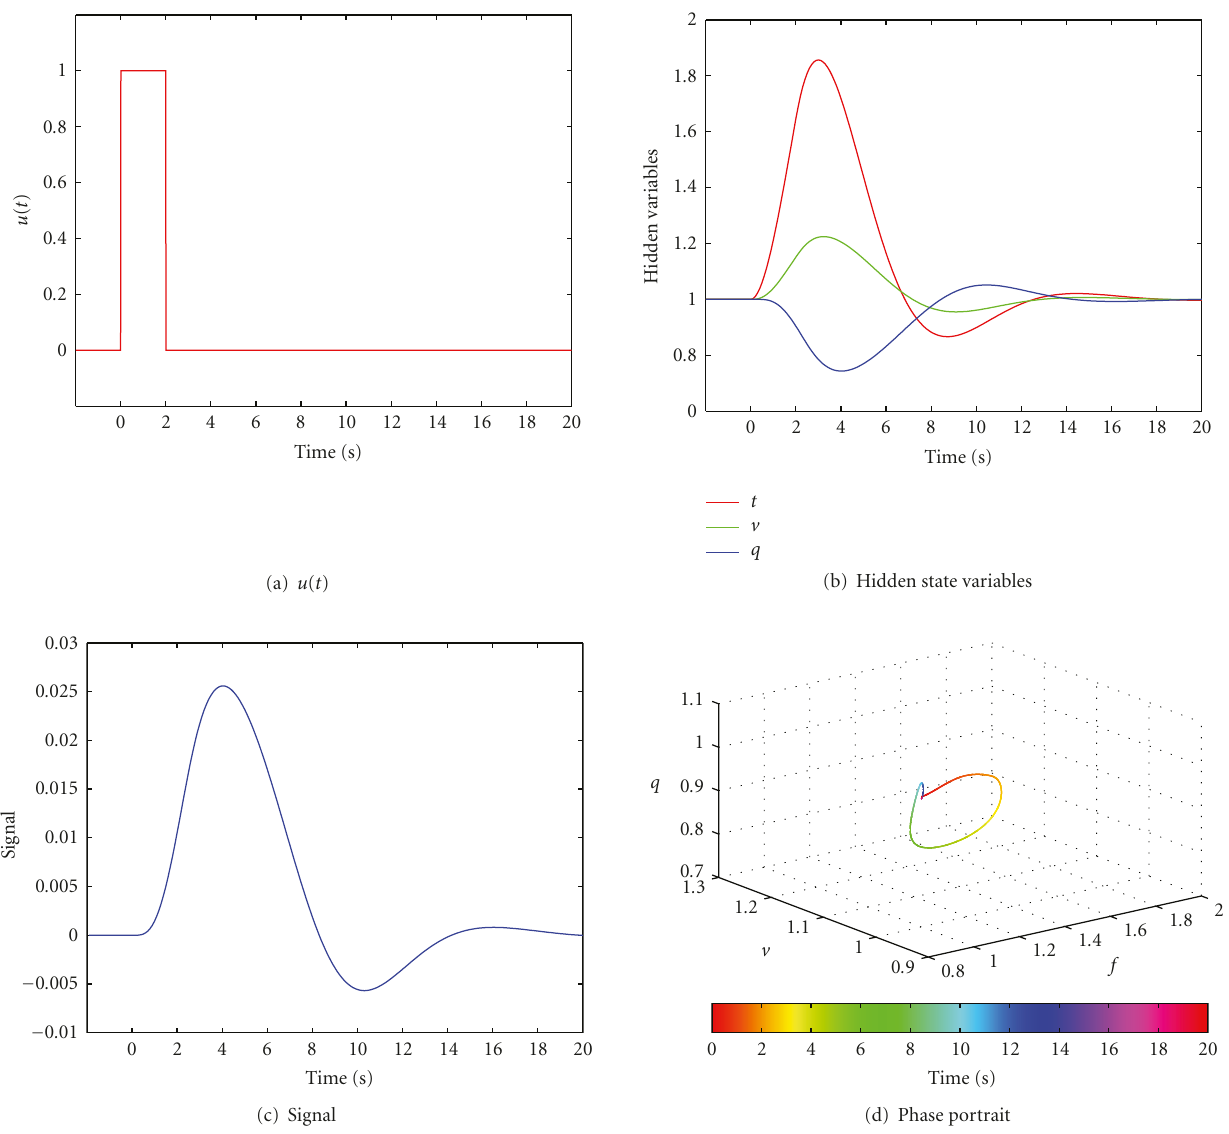
Figure 2: Simulation on an impulse input (1s) for typical parameter values. (a) impulse input; (b) the concomitant changes in blood flow ( f , red), venous volume ( v , green), and deoxyhemoglobin content ( q , blue); (c) the corresponding BOLD response; (d) phase portrait for a three dimensional ( f , q , v ) phase space. u ( t ) take the value 1 when the stimulus is ON and 0 when the stimulus is